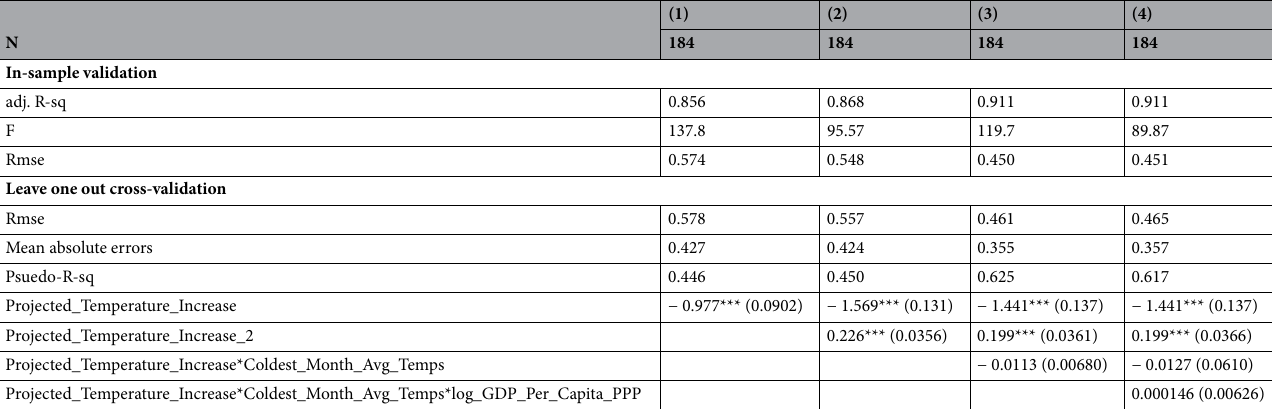
Table 2. Cold model validation. Cold model specification (3) performed the best out of the models both on in-sample validation and out of sample validation. Unlike the heat model, adding in the interaction with log GDP per capita did not improve the model performance. Standard errors in parentheses * p < 0.05, ** p < 0.01, *** p <